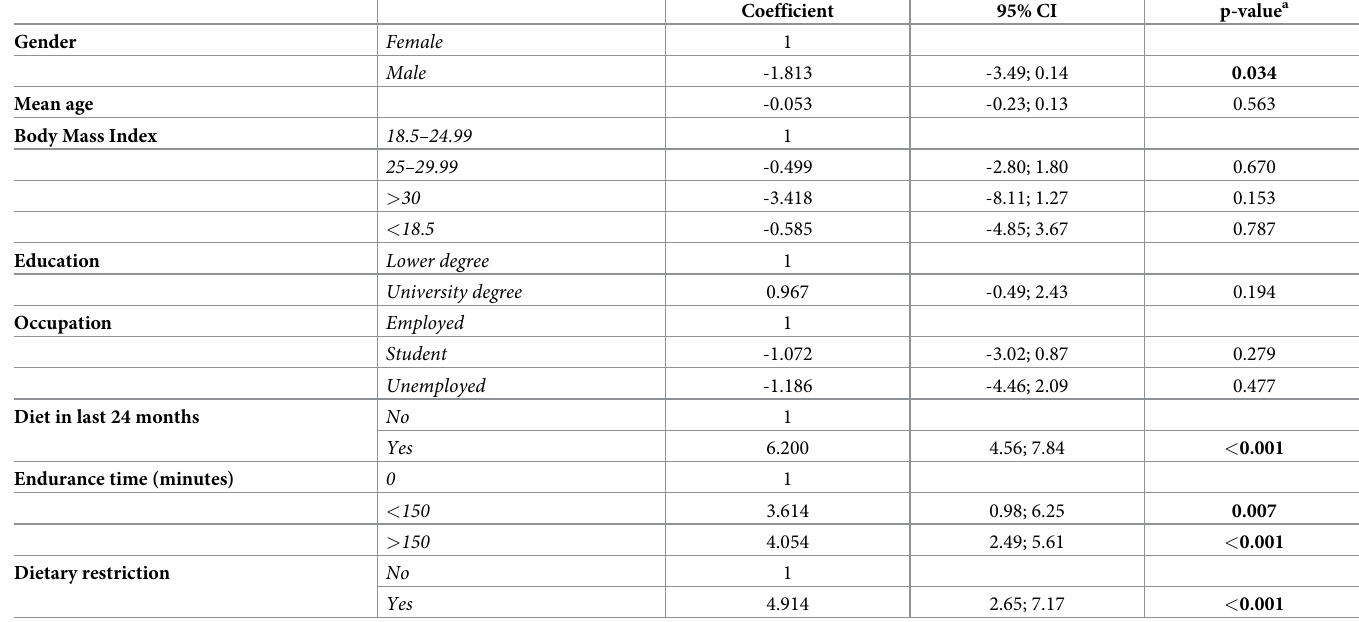
Table 4. Potential predictors of Orthorexia Nervosa evaluated by Eating Habit Questionnaire (continue variable), based on endurance activity minutes during the